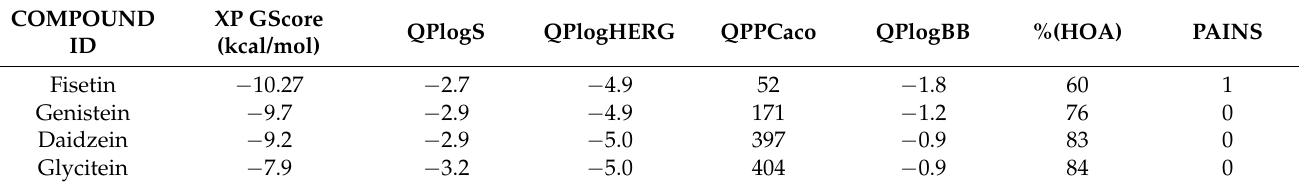
Table 4. XP GScore and physicochemical descriptors of the selected isoflavones.